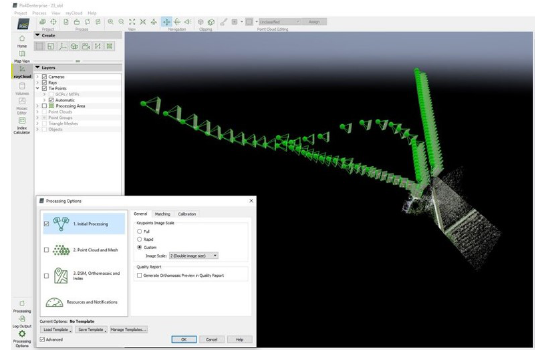
Figure 13. Pix4D could not calibrate all the images of the Oblique dataset despite of highest resolution setting in tie-point